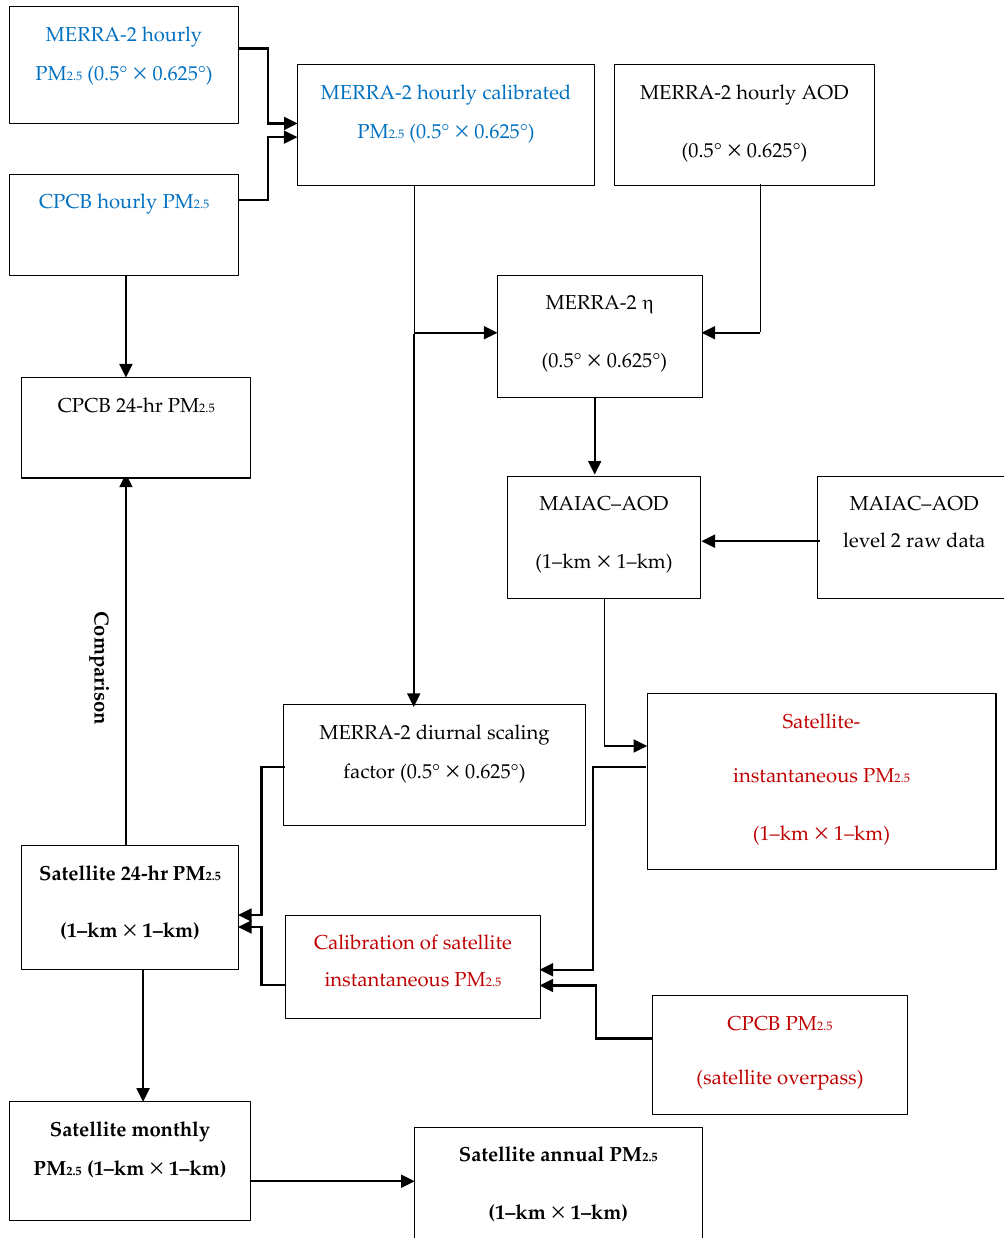
Figure 1. The flow chart of the entire process with the Modern-Era Retrospective analysis for Research and Applications Version 2 (MERRA-2) calibration steps shown in blue colored font, satellite fine particulate matter (PM 2.5 ) evaluation in red colored font and generation of the final products that are disseminated through the ‘satellite-based application for air quality monitoring and management at a national scale’ (SAANS) portal in bold black font.